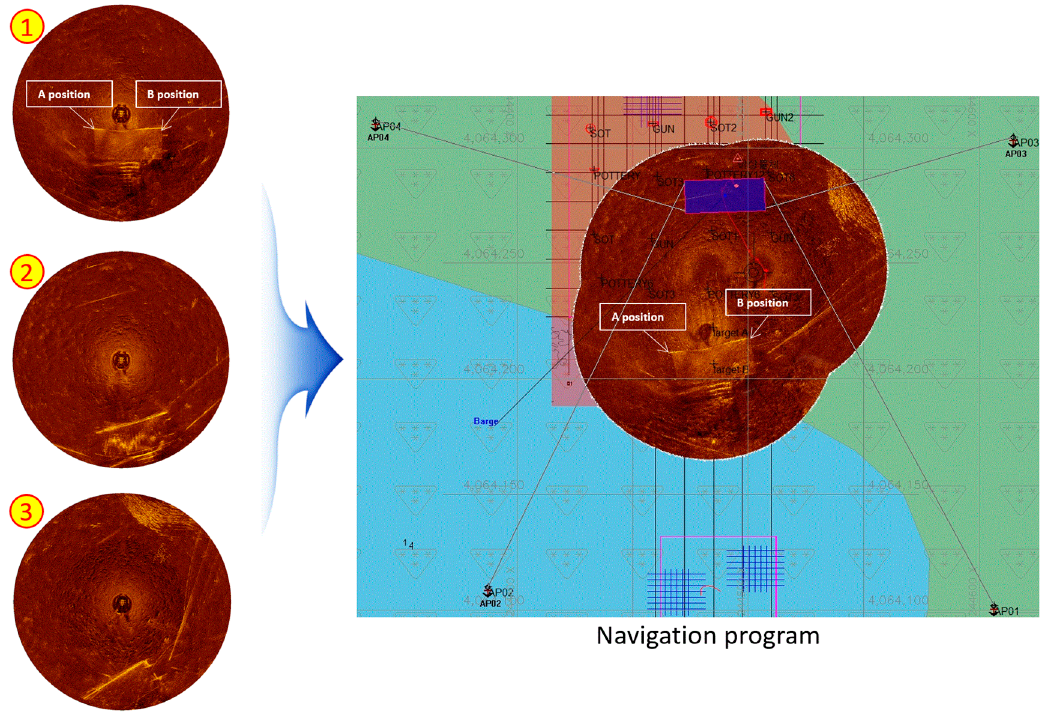
Figure 22. Application of the sonar mosaic image using the differential global positioning system (DGPS) information [32].